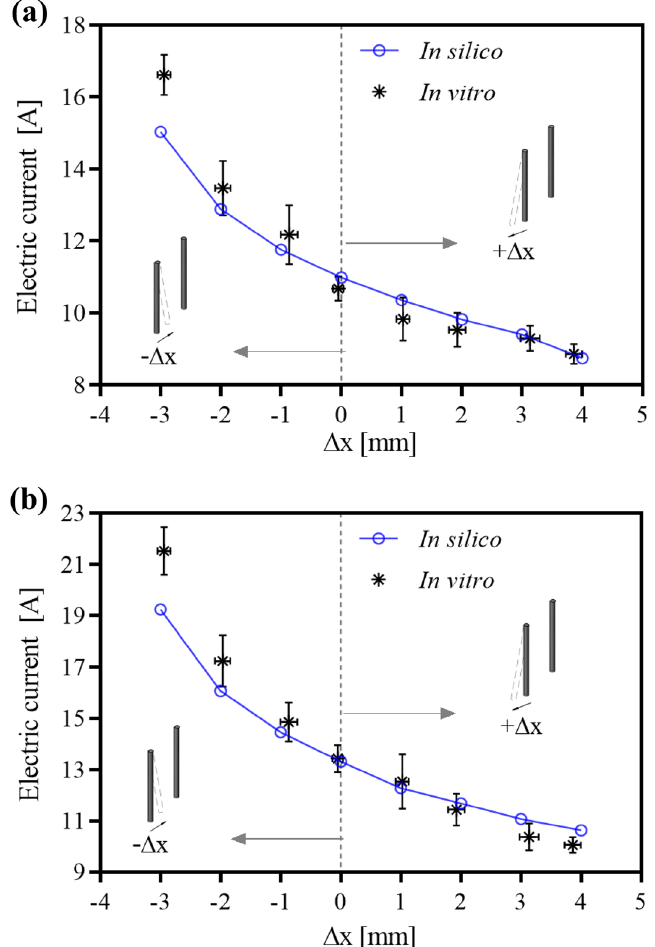
Figure 2. In silico and in vitro (mean and CI = 0.95) results of electric currents for ( a ) 3-pair and ( b ) 4-pair electrodes in Solanum tuberosum tissue. − Δx and + Δx represent inward and outward needle electrode deflections, respectively. The Δx uncertainty measurements are presented as means and CI = 0.95 (horizontal bars). In the case of 3 pairs, there are no statistical differences between the in silico and in vitro electric currents for Δx from −2 to 4 mm, and Δx from −1 to 2 mm in the case of 4